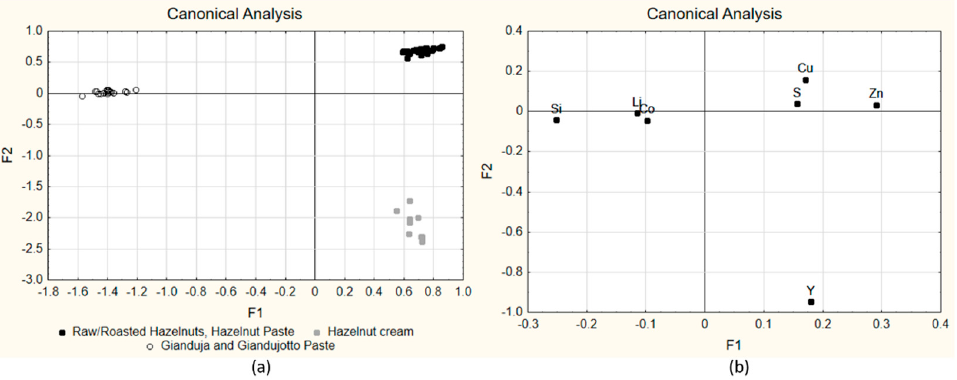
Figure 2. LDA score plot of the 54 samples, F1 vs. F2 for the classification according to the product type: score plot of the canonical variables ( a ); loading plot of the canonical variables ( b ).